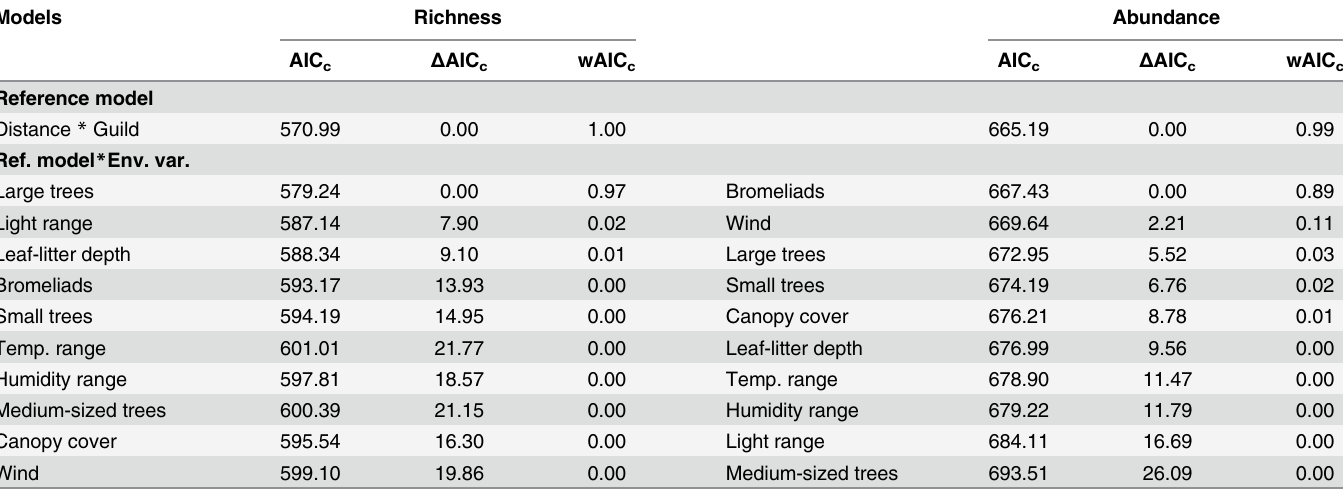
Table 2. Model comparison of frog richness and abundance. Response variables evaluated in relation to environmental variables (microclimate and habitat characteristics).